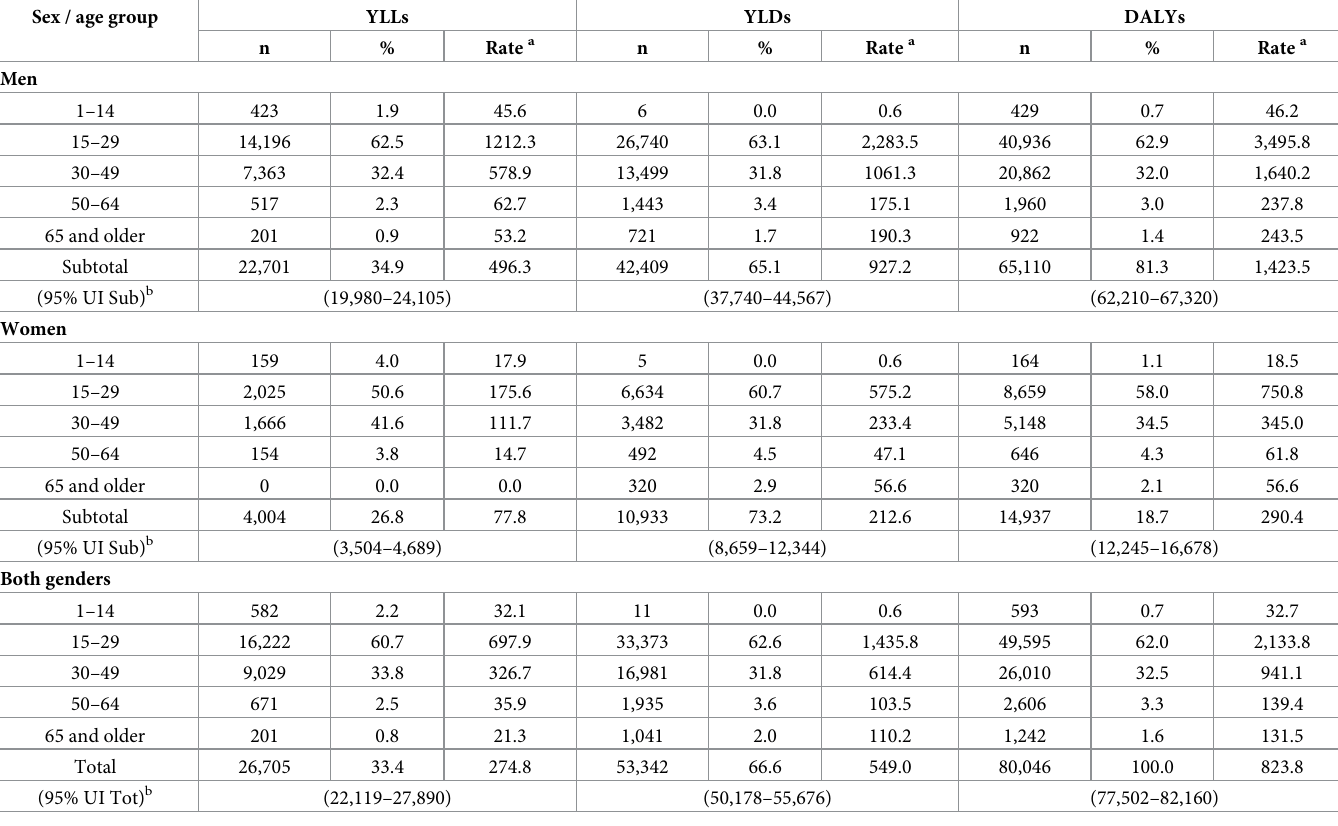
Table 2. YLLs, YLDs and DALYs due to road incidents of motorcyclists according to sex and age